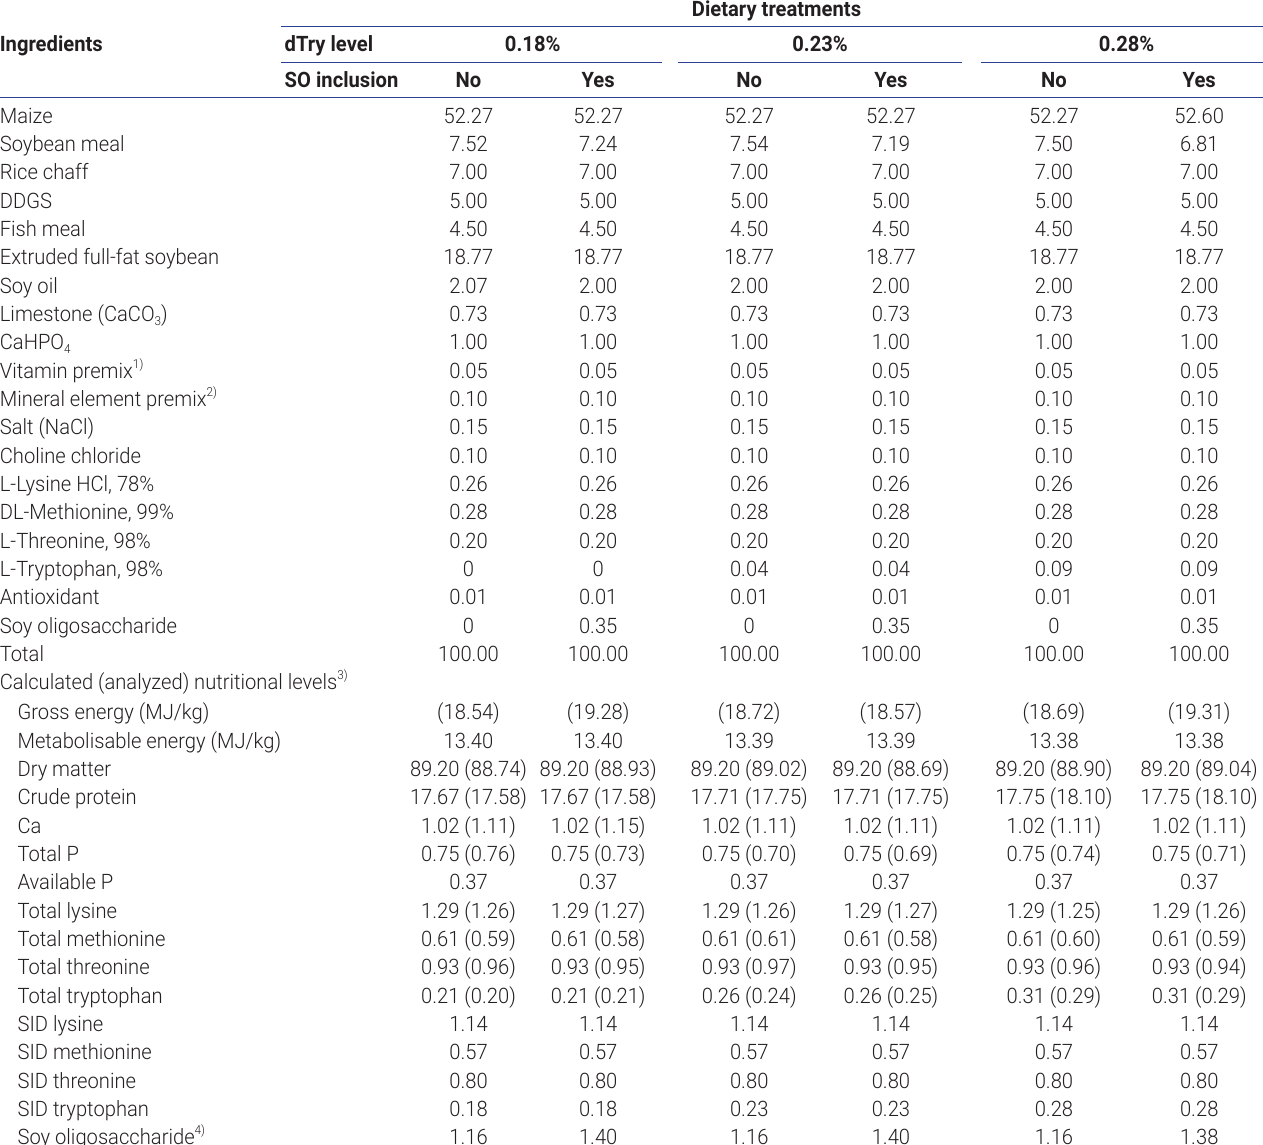
Table 1. Ingredients and chemical composition of the experimental diets for broiler chickens aged from 14 to 42 days (%,